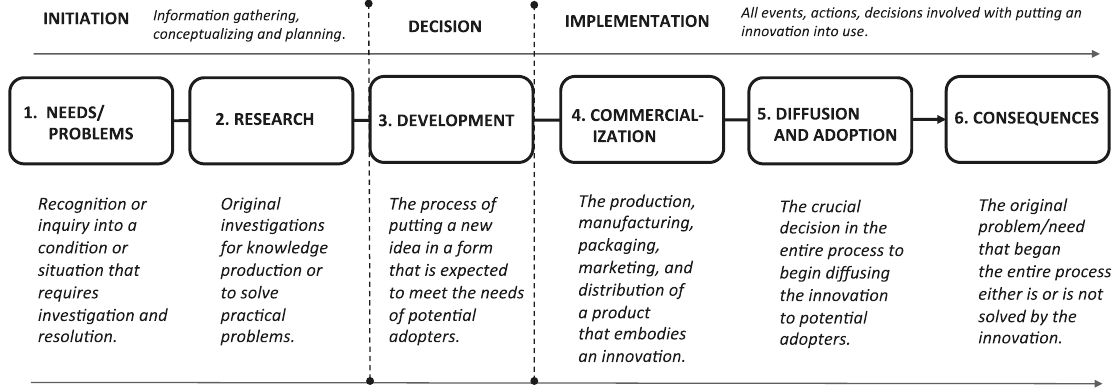
Fig. 3. Adaptation of E. Rogers’ six stages of the innovation development process Although Rogers argues these phases reflect a normative process, he does add that “The six phases described here may not always occur in a linear sequence, the time-order of the phases may be different, or certain phases may not occur at all” (Rogers, 1993:162). He suggests that research activities are most often how the initiation phase begins, and that the most crucial phase of decision-making is knowing if , how and when to begin diffusing an innovation to potential adopters. This prioritizing for the diffusion phase over the earlier phases is evident in most innovation process